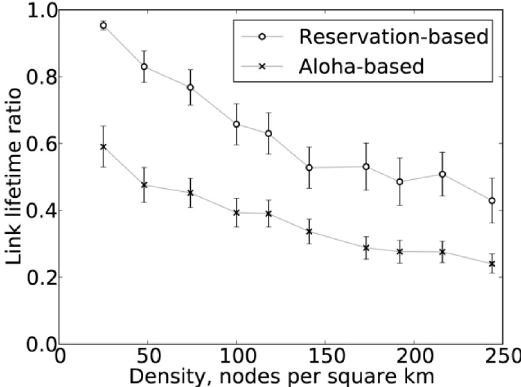
Figure 8. Mean unidirectional link lifetime ratio versus density in simulated environment.